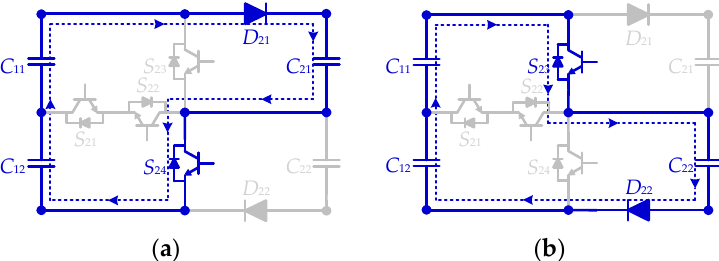
Figure 4. The charging principle of capacitors in the T-type switched capacitor module (TSCM). ( a ) The charging path of the first capacitor in the TSCM. ( b ) The charging path of the second capacitor in the TSCM.